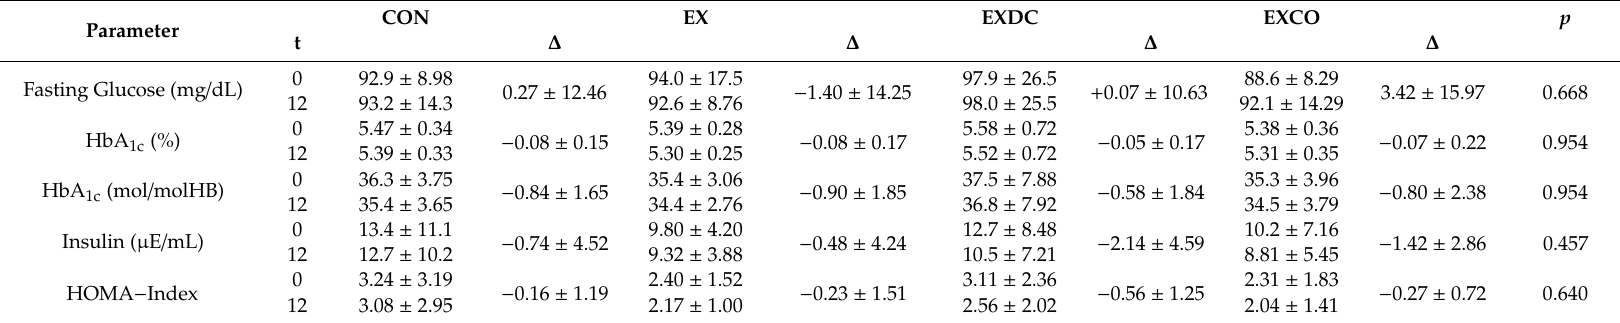
Values are given as mean ± SD. p values represent time*intervention interaction analyzed with two-way repeated measure ANOVA. In case of significance, asterisks indicate statistical di ff erences within groups detected with Bonferroni post hoc test (* p < 0.05; † p < 0.01; ‡ p < 0.001). t = time in weeks, BMI = body mass index, TBW = total body water, LBM = lean body mass, BCM = body cell mass, FM = fat mass. Table 5. Markers of glucose metabolism and absolute changes ( ∆ ) at the beginning (0) and at the end (12) of the intervention. CON Parameter Fasting Glucose (mg /